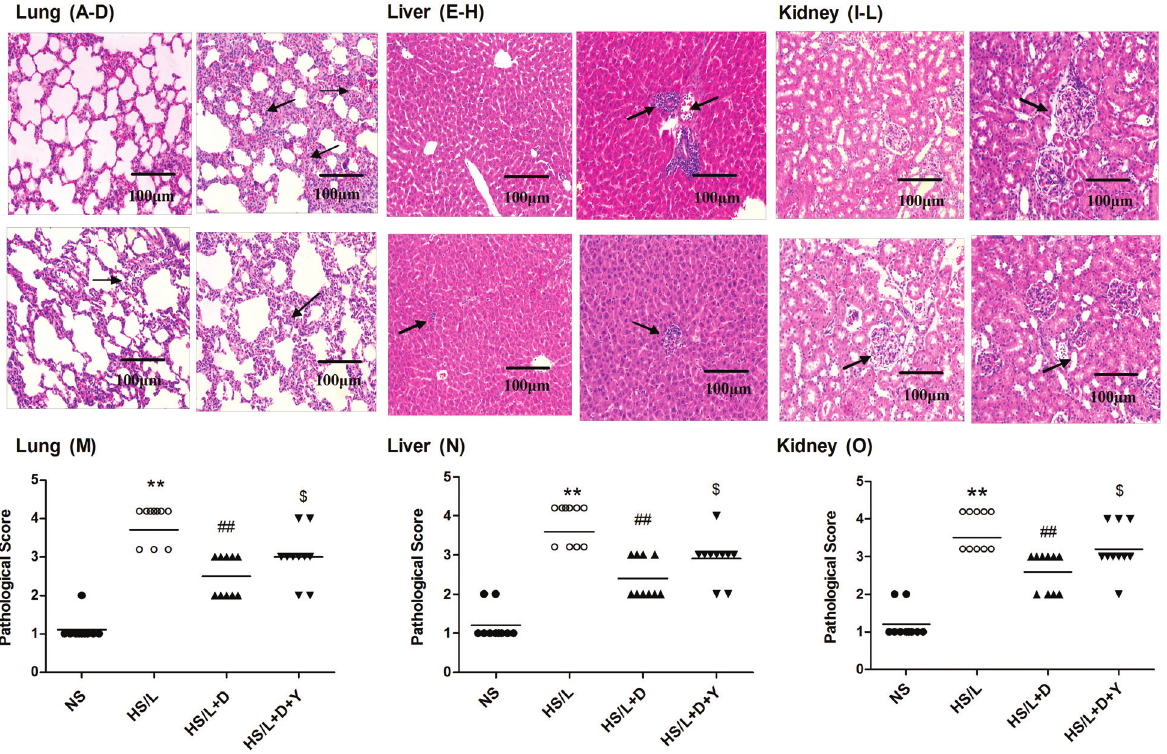
Figure 5. Representative microscopic fi ndings of the lung ( A - D ), liver ( E - H ), and kidney ( I - L ) tissues of the NS control (normal saline, n=10), hemorrhage/resuscitation plus lipopolysaccharide (HS/L, n=10), HS/L plus dexmedetomidine (HS/L + D, n=10), and HS/L + D plus yohimbine (HS/L + D + Y, n=10) groups (hematoxylin and eosin; (cid:1) 200, magni fi cation bar: 100 m m). Arrows indicate pathological changes. Histological injury scores for lung ( M ), liver ( N ), and kidney ( O ) tissues. Data are reported as means ± SD. **P o 0.01 vs the NS group; ## P o 0.01 vs the HS/L group; $ P o 0.05 vs the HS/L + D group (ANOVA).